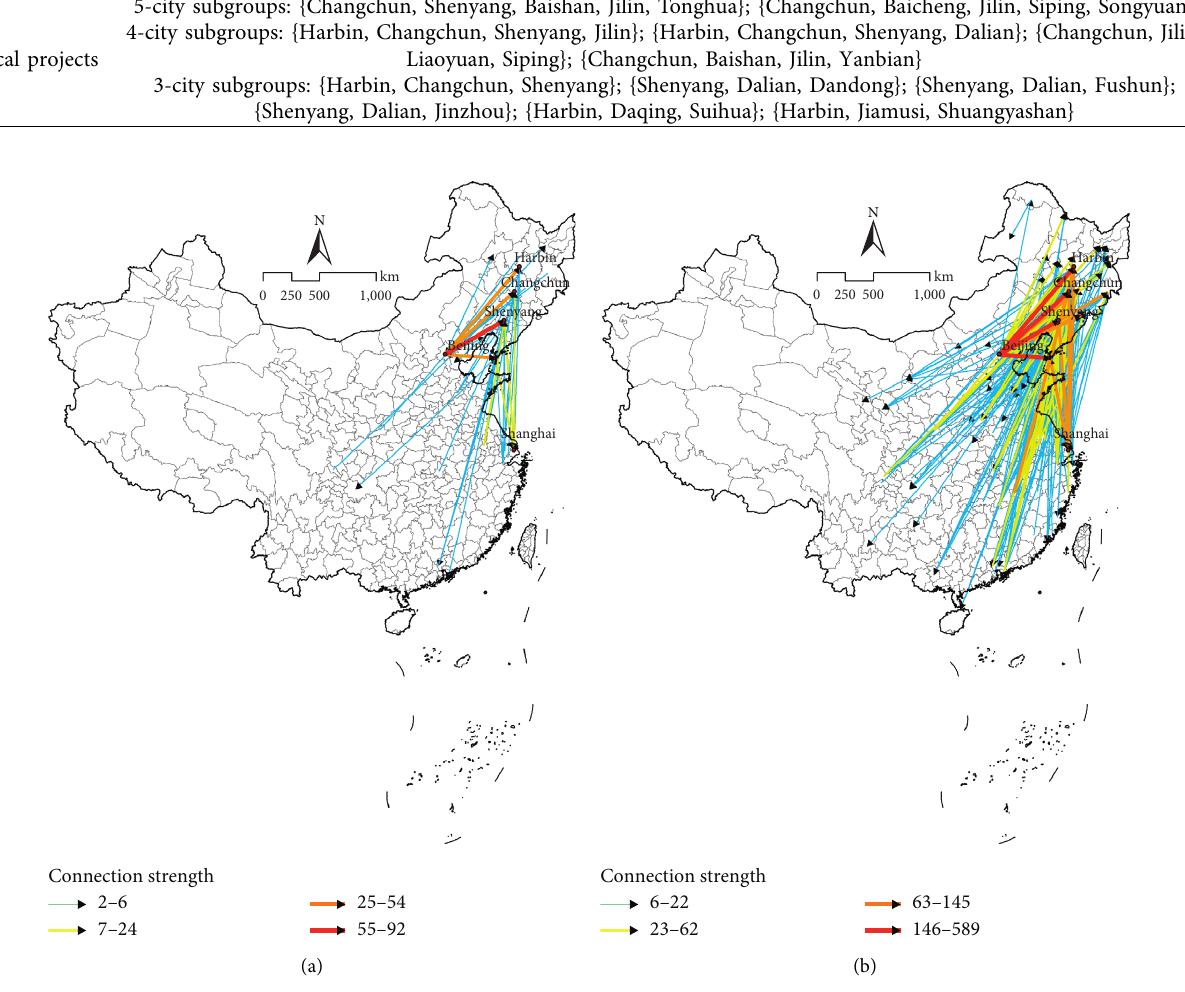
Figure 4: Spatial connection pattern of national networks. (a) Central projects. (b) Local projects.